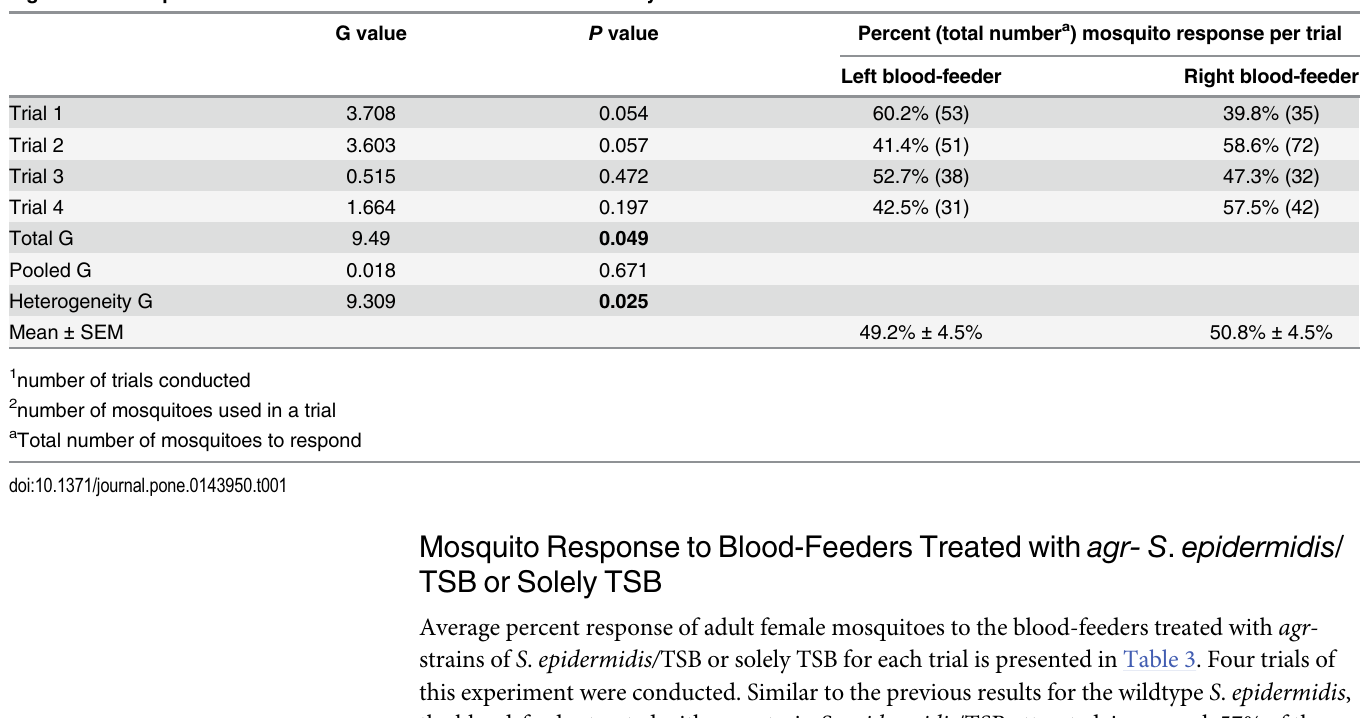
Table 1. Repeated G test of goodness-of-fit test, percent response per trial, and mean percent ± SEM across trials of the response of 5-8-d old Ae . aegypti (N 1 = 4; n 2 = 50) adult female attraction to blood-feeders located on opposite sides of the top of a 82 cm x 45 cm x 52 cm Plexiglas cage dur- ing 15-minute experiments at 25°C and 80% RH and treated with solely TSB.